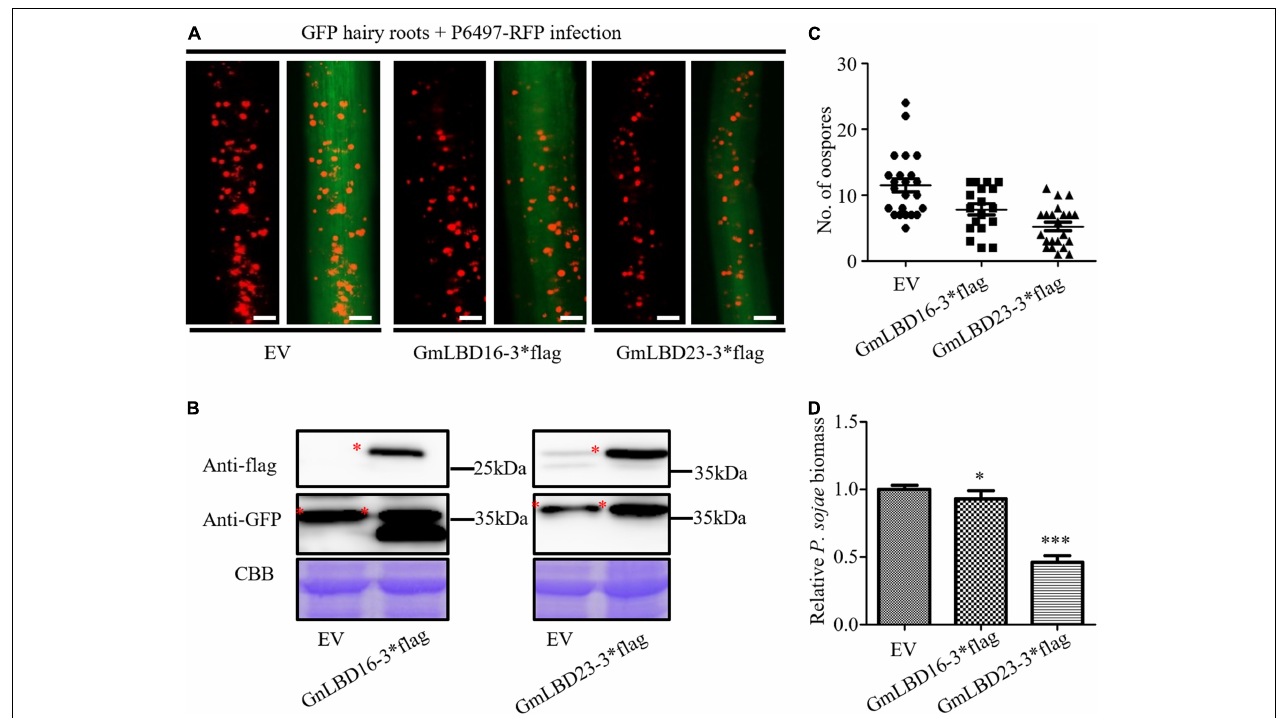
FIGURE 6 | Overexpression of GmLBD16 and GmLBD23 suppressed P. sojae infection. (A) Soybean hairy roots overexpressing EV or GmLBD16-3 ∗ flag and GmLBD23-3 ∗ flag were selected based on the green fluorescence and then inoculated with P. sojae strain P6497-RFP. P. sojae oospores were observed at 48 hpi under a fluorescence microscope. Scale bars represent 0.28 mm. (B) Expression of recombinant proteins EV, GmLBD16-3 ∗ flag, and GmLBD23-3 ∗ flag was detected in western blot. Protein gel was stained with Coomassie blue as the loading control. (C) The number of oospores was counted. (D) Relative biomass of P. sojae was determined by qPCR at 48 hpi, and standard errors from three replicates are shown ( ∗ P < 0.05; ∗∗∗ P < 0.001; one-way